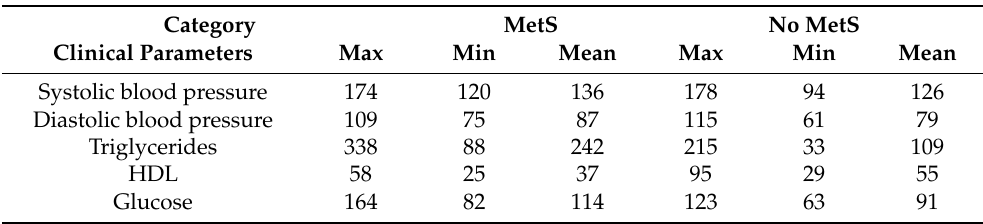
Table 1. The distribution of the clinically measured parameters in MetS and no MetS patients expressed in mg/dL and in